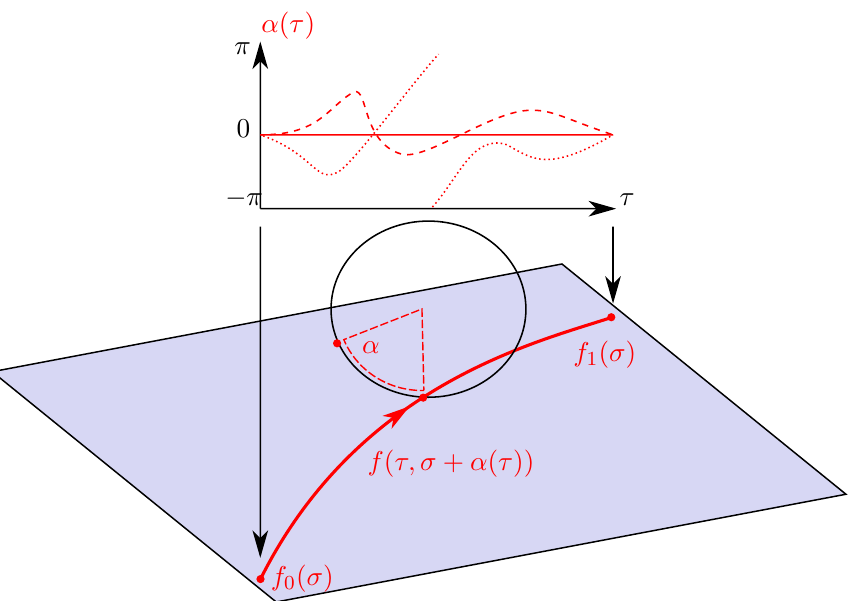
Figure 1 . The space of allowed maps can be described via circular fibres over a base-space. This base space can be described as the space of allowed maps for which f (0) = 0 , while the points along the fibre have f ( α ) = 0 . The circuit f ( τ, σ ) = f ( τ + σ ) is trivially a geodesic for any Π and winds around such a fibre as an uncontractible cycle, see section 4.2. Assume for a given Π , a geodesic circuit f ( τ, σ ) (solid red curve) connects two points f 0 ( σ ) , f 1 ( σ ) in the base space (shaded area). If the cycles are null, then this circuit can be wiggled along the circle by an arbitrary function α ( τ ) (solid, dashed and dotted red lines above), and f ( τ, σ + α ( τ )) will still be a geodesic of identical length — the geodesic problem on the degenerate metric has a U(1) -gauge